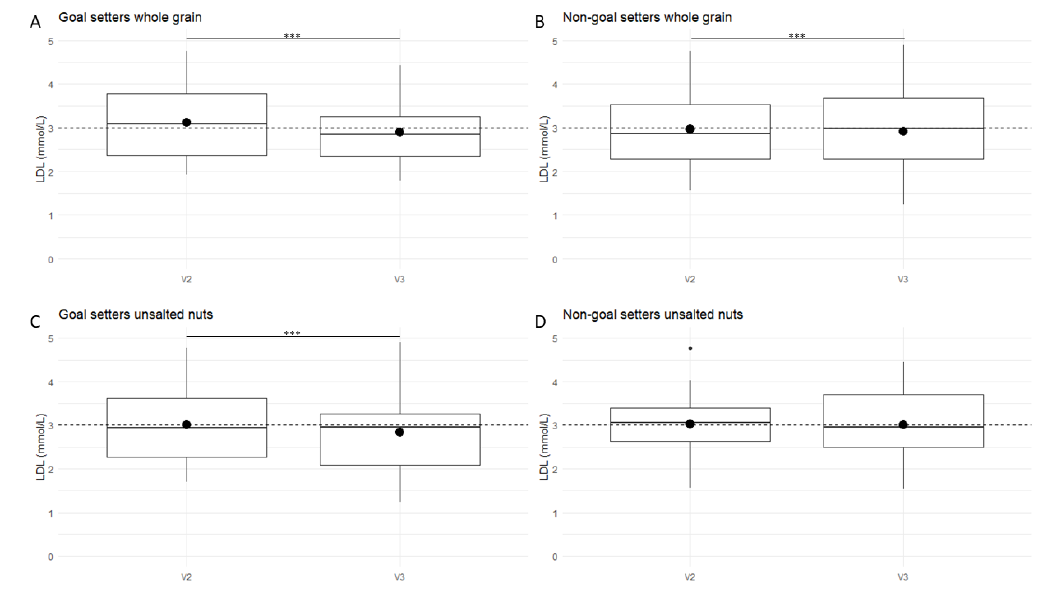
Figure 5. Changes in LDL cholesterol ( A ) goal-setters for whole grain, n = 18; ( B ) non-goal-setters for whole grain, n = 32 ( C ) goal-setters for unsalted nuts, n = 29; ( D ) non-goal-setters for unsalted nuts, n = 21. Data presented as descriptive boxplot, in which the center represents the median, the outlines of the box indicate quartile 1 or 25th percentile and quartile 3 or 75th percentile and the top of the line shows the most extreme data points within 1.5 times the IQR. The full circle in the boxplots represents mean LDL cholesterol. Dotted line represents an LDL cholesterol of 3.0 mmol/L. An LDL below 3.0 mmol/L is healthy, according to the Dutch Heart Association (https://www.hartstichting.nl/). *** p < 0.001. PNA—personalized nutrition advice.